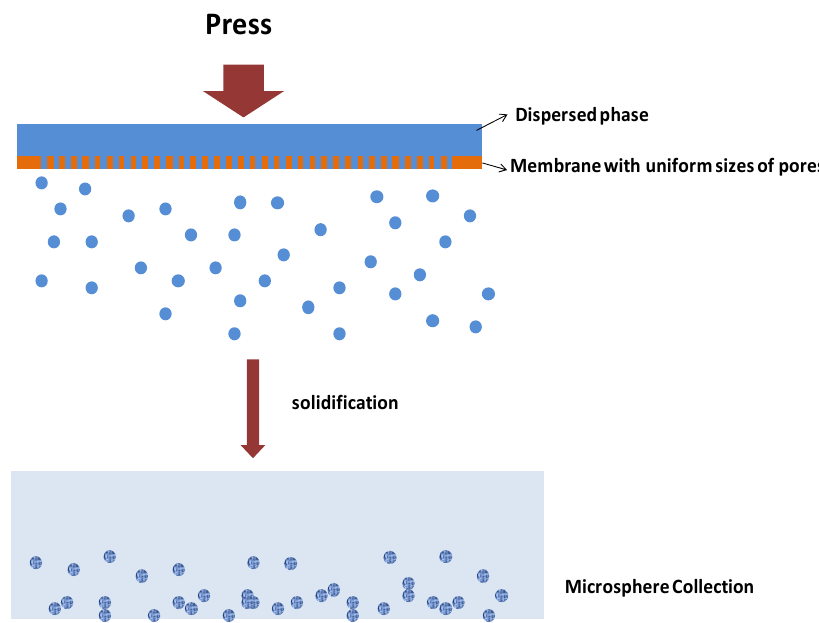
Figure 4. Schematic description of processes of direct membrane emulsification method.